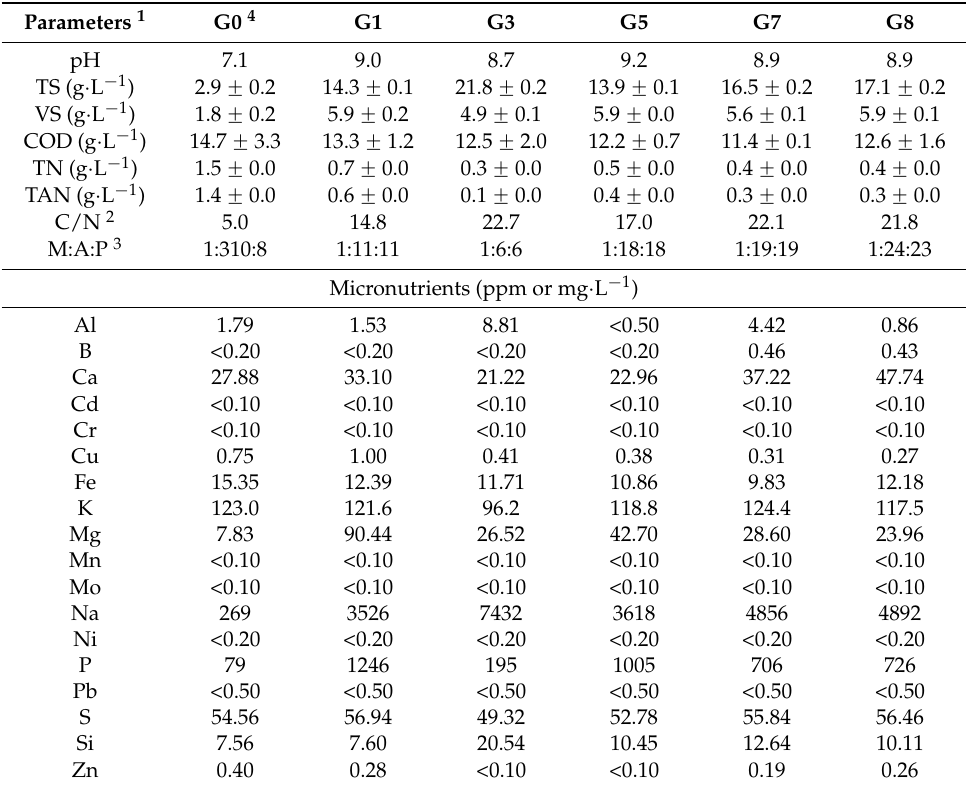
Table 4. Characteristics of untreated (control) and treated substrates by struvite precipitation used for BMP